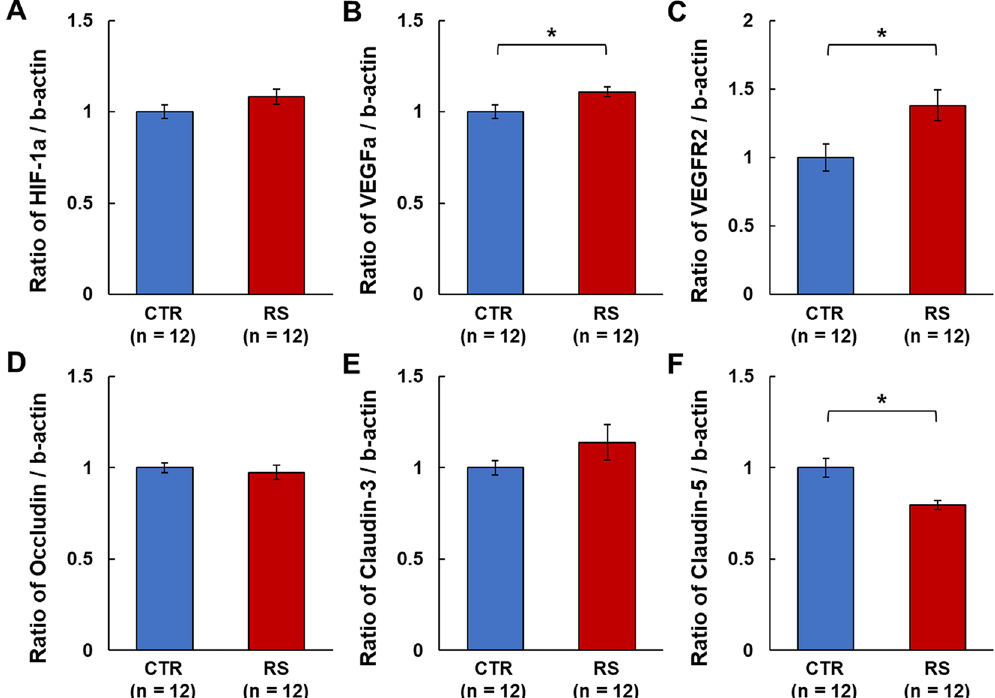
Figure 5. mRNA expression of hypoxia related factors and tight junction proteins underlying BBB permeability. ( A – C ) The expression of hypoxia related factors, HIF-1 α , VEGFa, and VEGFR2 in the somatosensory cortex. ( D–F ) The expression of tight junction proteins, occludin, claudin-3, and claudin-5 in the somatosensory cortex. CTR, control group; RS, restraint stress group; * p <